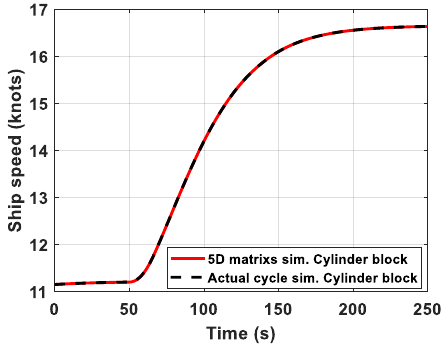
Figure 17. Ship speed time history.